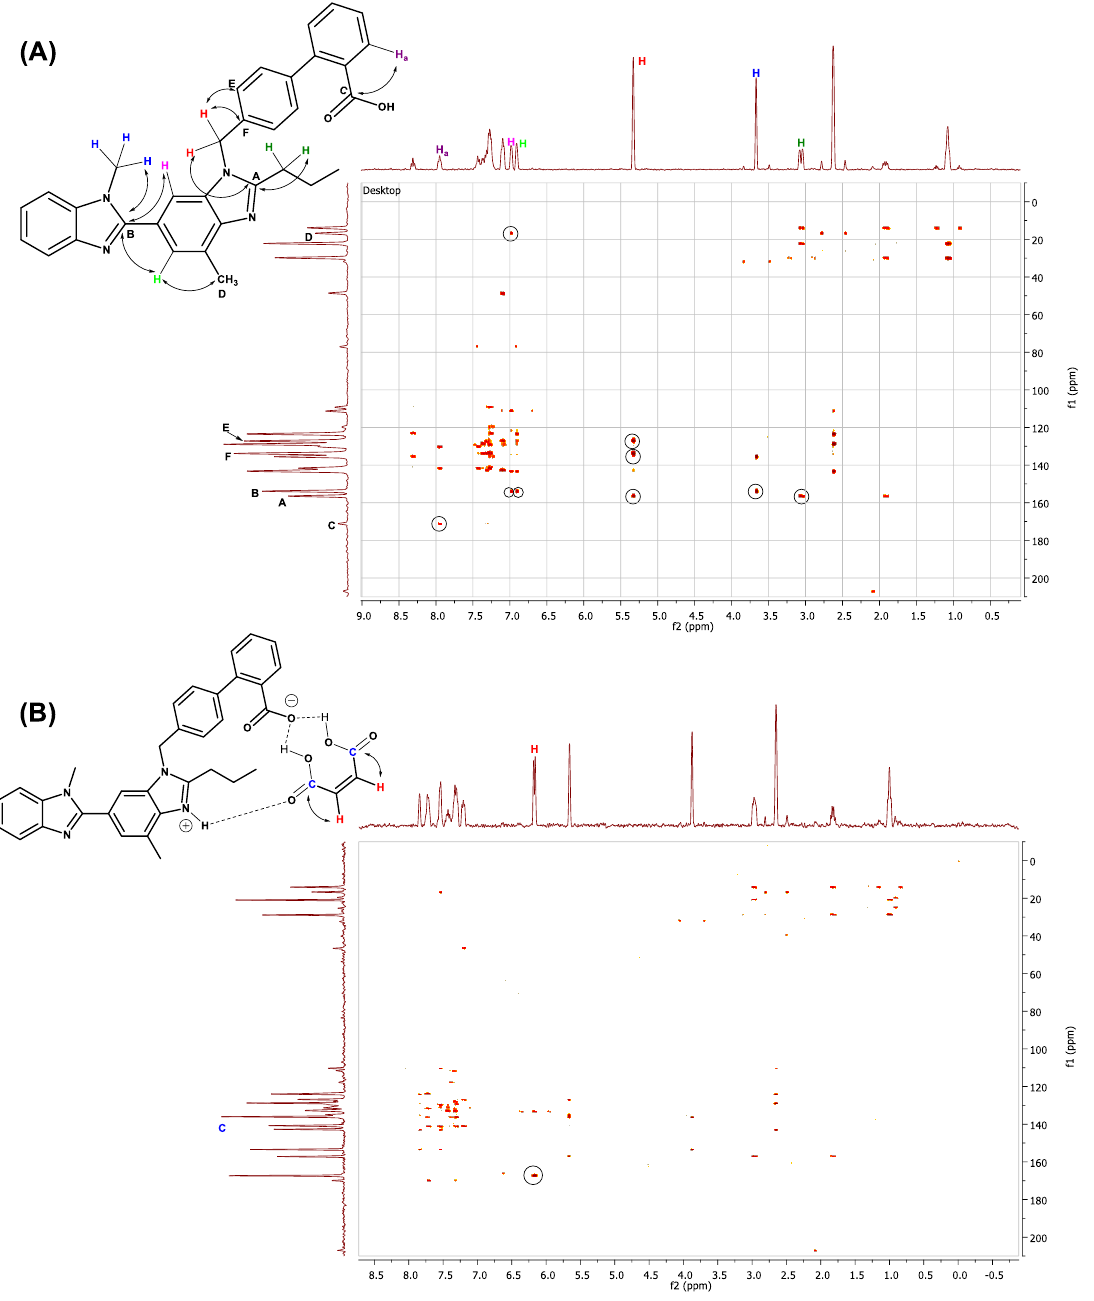
Figure 16. 1 H- 13 C HMBC analysis of ( A ) Pure telmisartan. ( B ) Cocrystal . By looking at the pure TEL HMBC NMR image (Figure 16A) and comparing it with